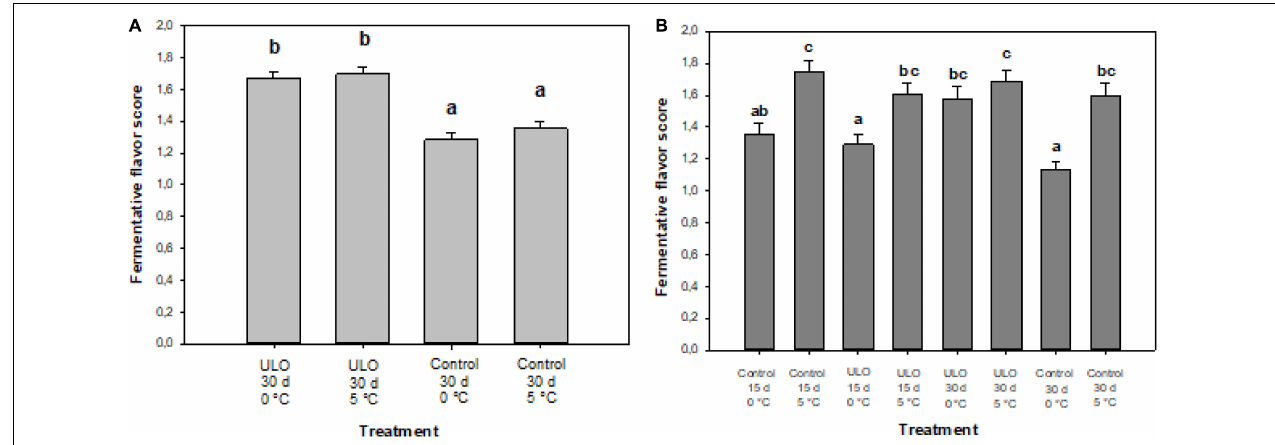
FIGURE 4 | Fermentation flavor score in ‘Fuji’ apple affected by conditioning under ULO for 15 or 30 days at 0 or 5 ◦ C and evaluated after (A) 30 days of preconditioning and (B) 90 days at 0 ◦ C. Scores were taken as 1 (normal flavor) and 2 (fermentative flavor). Means with different letters are significantly different according to Tukey’s multiple comparison test ( P ≤